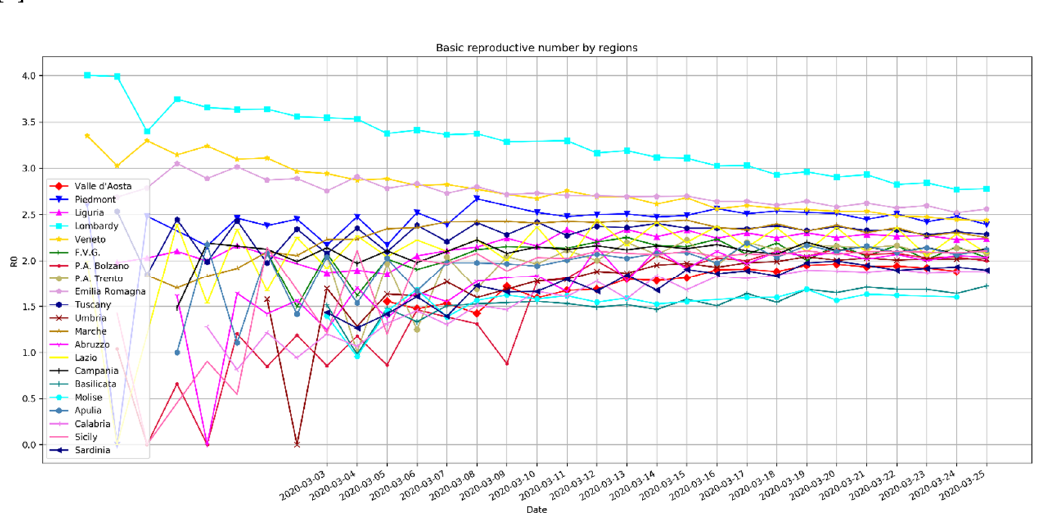
Figure 3. Basic reproductive index computed on a daily basis with the second method investigated in this letter.